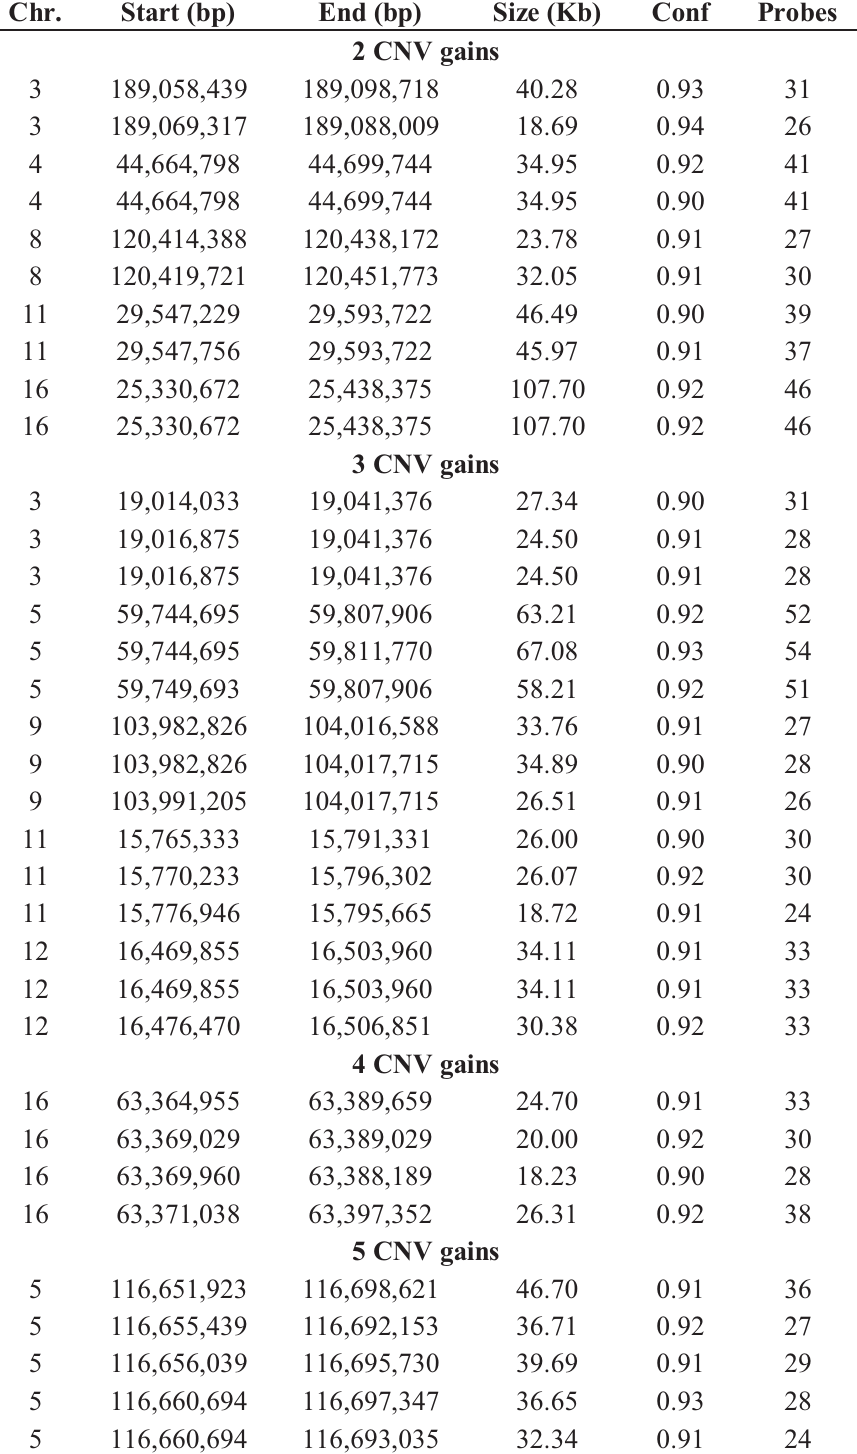
Table 4. Genomic regions associated with unique CNVs (compared to controls) identified across multiple among patients. Note CNV frequency and CNV type; CNV location (chromosome, start bp and end bp) and size; as well as the confidence score associated with CNV call and the number of probes used to call the CNV are also noted.